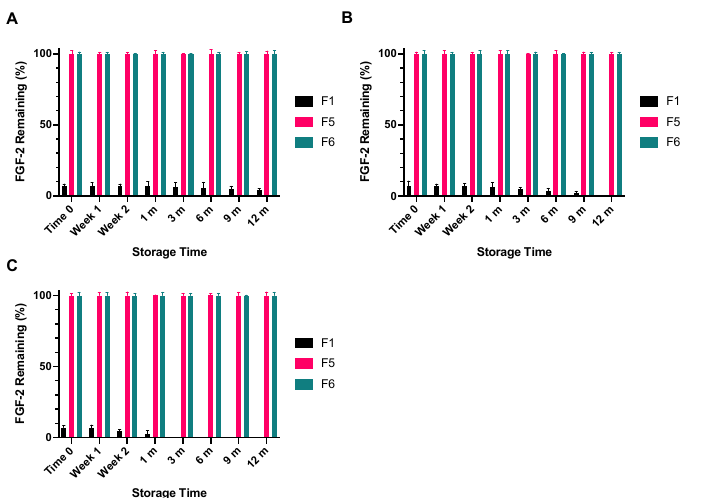
Figure 9. Stability of FGF-2 aqueous solutions (770 ng/mL) upon lyophilisation and storage. FGF-2 in solutions F1 (water alone), F5 (MC 0.05% w/v and alanine 20 mM) and F6 (MC 0.05% w/v and HSA 1 mg/mL) were lyophilised over 24 h then stored at − 4 °C ( A ), 4 °C ( B ) or 18 °C ( C ) for up to 12 months. At defined storage time points, the lyophilised powders were reconstituted with water and the FGF-2 content as determined by ELISA is expressed as a percentage of the baseline FGF-2 con- tent determined in the FGF-2 solutions prior to lyophilisation (mean ± SD, n = 3). The lyophilised F1, F5 and F6 powders following storage at − 4 °C, 4 °C or 18 °C for specified time points were reconstituted with water and the resultant solutions were stored at either 4 °C or 18 °C for 24 h or 7 days. Solutions prepared by reconstituting the lyophilised F1 powder were not stable to storage at 4 °C or 18 °C for 24 h, the FGF-2 con- tent in all F1 reconstituted solutions falling below the detectible limit of the ELISA assay (data not presented). By comparison, the solutions reconstituted from the lyophilised F5 and F6 remained stable for not only 24 h (Figure 10) but also 7 days (Figure 11) at both storage temperatures, retaining >99% of the baseline FGF-2 content throughout the pre- scribed storage conditions.